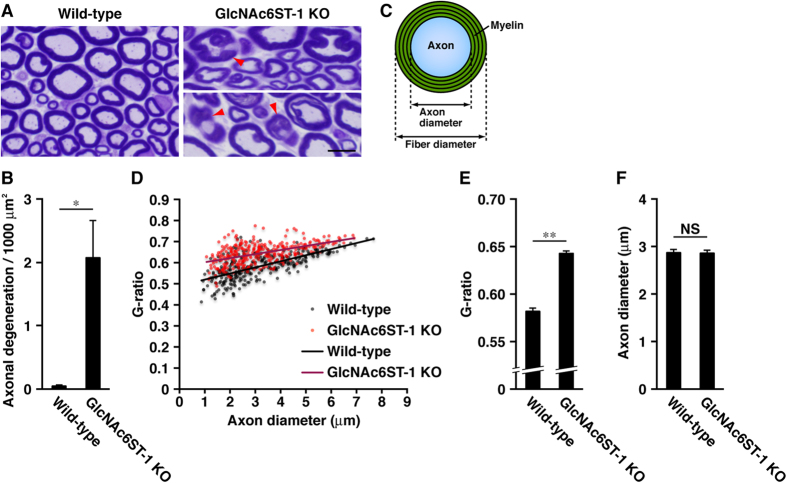
GlcNAc6ST-1-knockout mice display axonal degeneration in the PNS.(A) Semi-thin cross sections of sciatic nerves from young adult WT and GlcNAc6ST-1-KO mice were stained with toluidine blue. Arrowheads indicate degenerating axons. Scale bar, 10 μm. (B) The numbers of degenerating axons were counted in the sciatic nerves of young adult WT and GlcNAc6ST-1-KO mice. Unpaired, two-tailed Student’s t-test; *P < 0.05. Data are shown as the mean ± SEM (n = 4 mice for each group; areas greater than 320,000 μm2 were counted). (C) G-ratio calculation for a myelinated axon. G-ratio = axon diameter/fiber diameter. (D) Scatter plot displays g-ratios as a function of axon diameter measured in the sciatic nerves of young adult WT (black) and GlcNAc6ST-1-KO (red) mice. (E) Myelin sheath thickness was quantified using the g-ratio in sciatic nerves of WT and GlcNAc6ST-1-KO mice. (F) Average diameters of myelinated axons in the sciatic nerves of young adult WT and GlcNAc6ST-1-KO mice. Unpaired, two-tailed Student’s t-test; **P < 0.01. Error bars indicate the mean ± SEM (>300 myelinated fibers from each group; n = 3 mice from each group). NS, not significant.